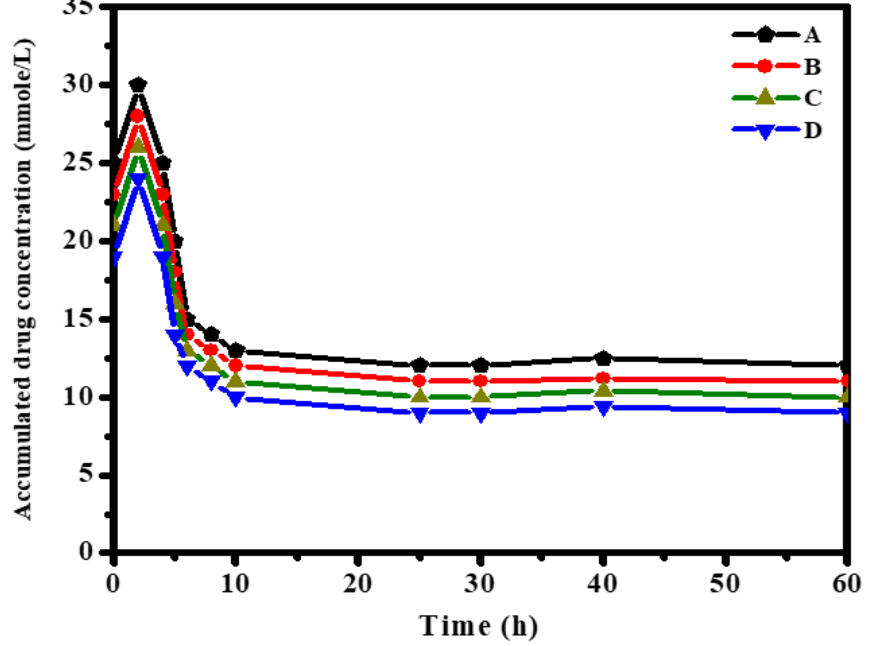
Figure 4. Release of 3β -cloro- 5α -cholestano- 2′ -methyl-2-oxazoline (A), 3β -acetoxy- 5α cholestano - 2′ - methyl-2-oxazoline (B ), 3β -chloro-N-amido- 5α -cholestano-aziridine (C ) and 3β -acetoxy- N-amido- 5α -cholestano-aziridine (D) from electrospun CH/PVP (25/75 wt. ratio) nanofibers.